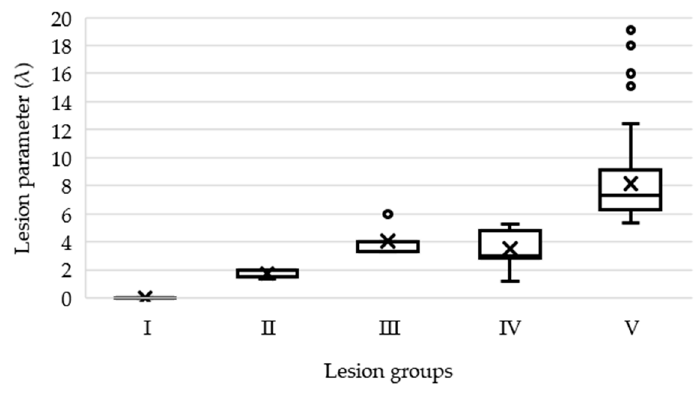
λ ) for each lesion